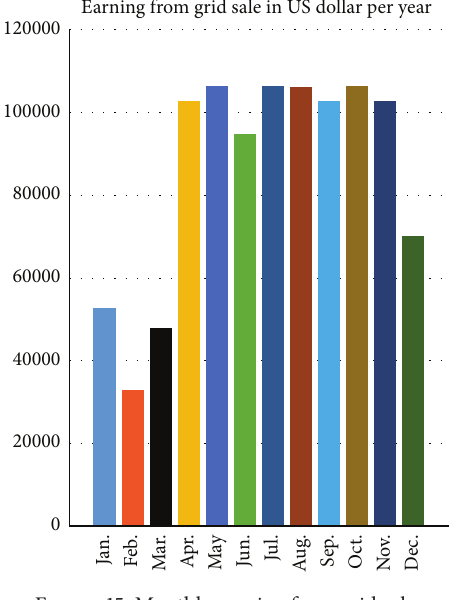
Figure 15: Monthly earning from grid sale.